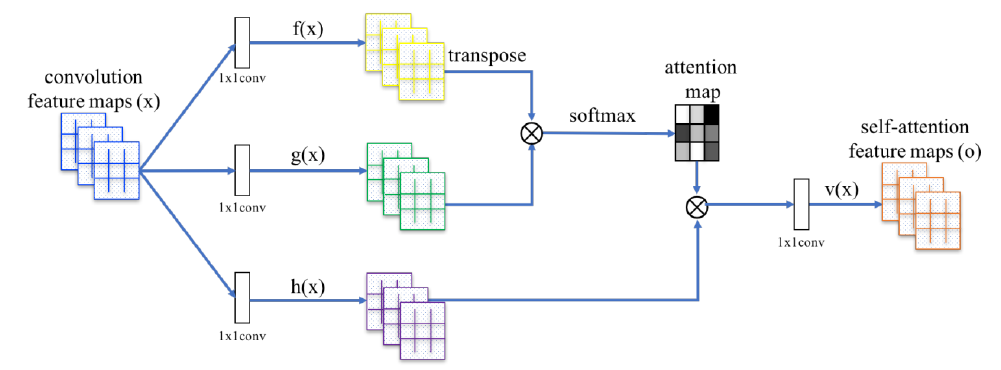
Figure 7. The block diagram of the self-attention layer [38].